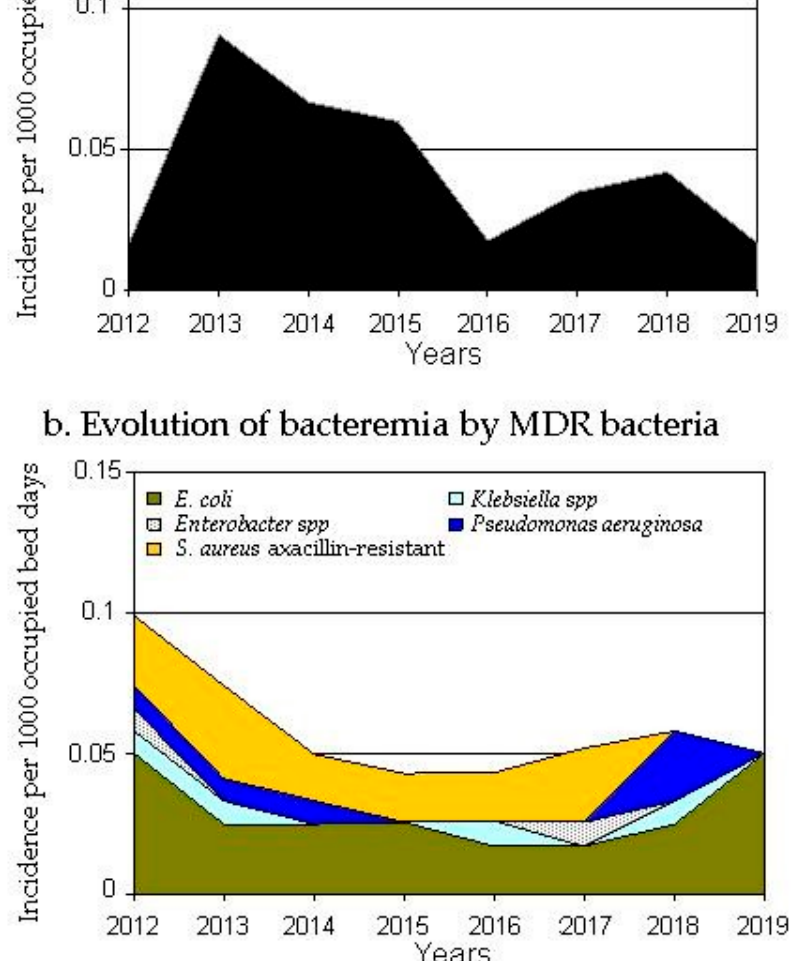
Figure 3. Evolution of the incidence density of candidemia and MDR bacteria isolated most frequently in ‐ hospital bloodstream infections.